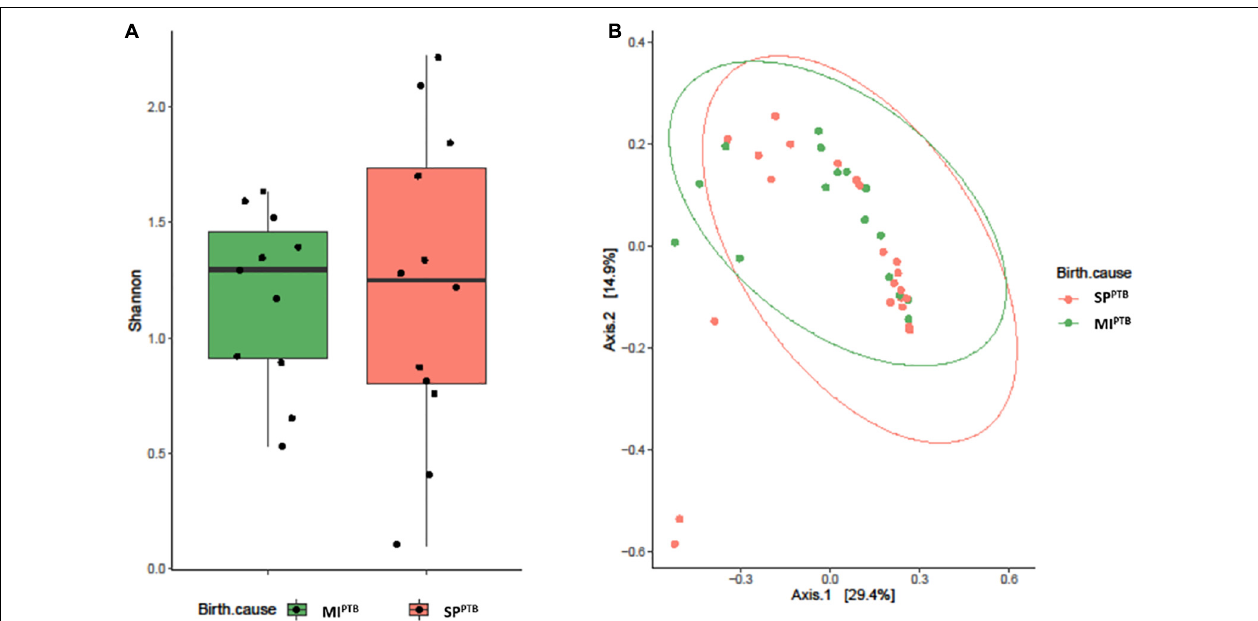
FIGURE 2 | Alveolar microbiota Alpha and Beta diversity analysis of preterm newborns classified on the basis of preterm birth subtype (MIPTB and SPPTB). Alpha diversity was evaluated by Shannon index measure. The values obtained were compared, resulting in no statistically significant difference between MIPTB and SPPTB infants’ groups (Mann–Whitney U -test) (A) . Comparison for Beta diversity analysis was made using Jaccard distance. The principal coordinate analysis (PCoA) results are presented as two-dimensional ordination plots, which were generated using two principal coordinates (i.e., axis 1 and axis 2) (B) . The statistical significance at a P -value of ≤ 0.05 was assessed using the permutational multivariate analysis of variance (PERMANOVA).